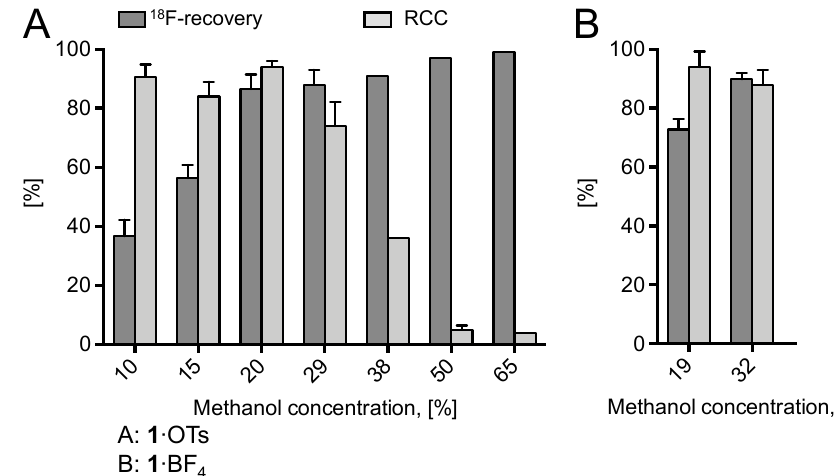
Figure 2. 18 F-Recovery and 18 F-incorporation (RCC) using di ff erent concentrations of MeOH. Conditions: A [ 18 F]Fluoride (50–200 MBq) was eluted from the respective anion exchange cartridge (see legend of Figure 1) with a solution of 1 · OTs (9.2 mg, 21 µ mol) in MeOH / DMF (620 µ L; di ff erent ratios of MeOH / DMF) directly to a solution of Cu(MeCN) 4 OTf (7.9 mg, 21 µ mol) in DMF (600 µ L)